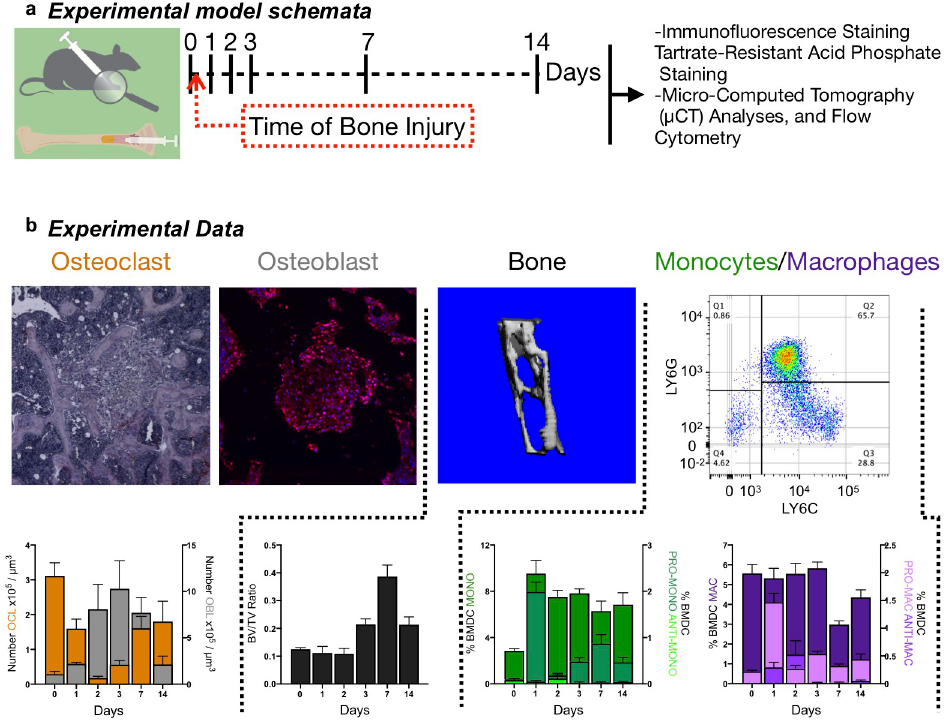
Fig 1. Experimental quantification of osteoblast, osteoclast, bone volume, and monocyte-macrophage over time during bone injury. a schematic summarizing the experimental system and the time course and different measurements performed. b from left to right: Decalcified bones were stained and quantified for OCL by tartrate- resistant acid phosphatase (TRAcP) staining (top left panel; red). Temporal quantification of OCL population was then assessed (bottom left panel); Decalcified bones were stained and quantified for OBL by RUNX2 immunofluorescence staining (second top panel; red). Temporal quantification of OBL population was then assessed (bottom left panel); micro-computed tomography revealed trabecular bone status. Representative images (third top panel) and corresponding quantitative analyses of bone volume on the top panel (BONE; BV/TV, second bottom panel). Flow cytometry was to gate and quantify monocytes-macrophages by the use of CD11b, Ly6C, Ly6G markers (Top right panel). Temporal quantification of na ï ve, pro-inflammatory and anti-inflammatory monocytes-macrophages populations was then assessed (bottom right